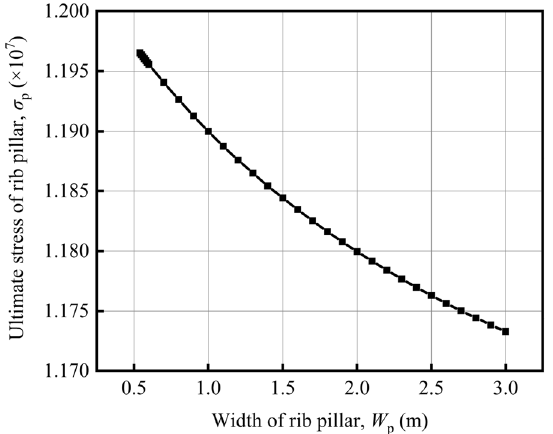
Fig. 16 Ultimate stress of the rib pillar under the No. 1 haulage bench